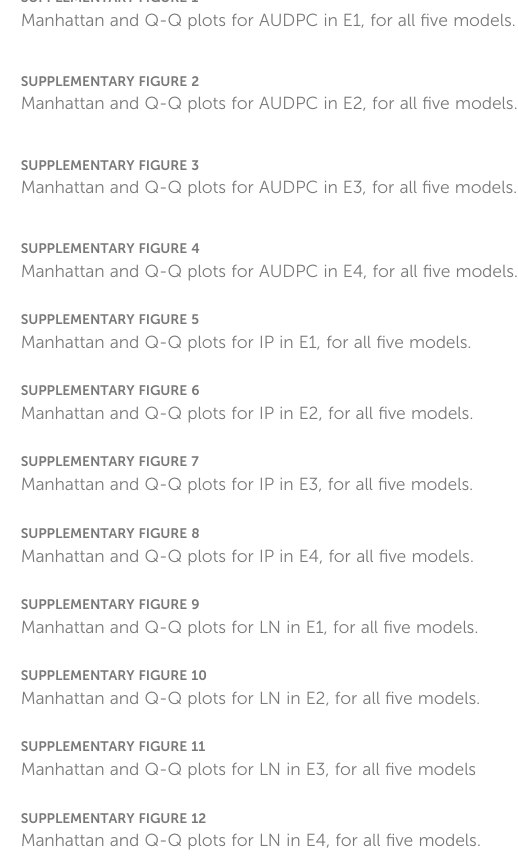
SUPPLEMENTARY FIGURE 2 Manhattan and Q-Q plots for AUDPC in E2, for all fi ve models.